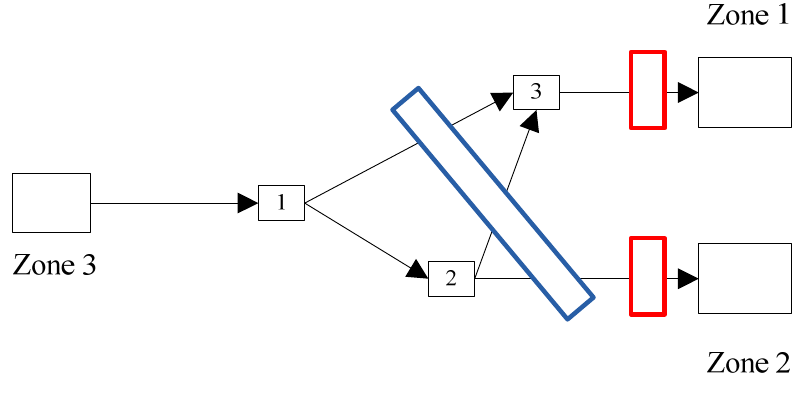
Figure 4. Example case to explain mobile sensor